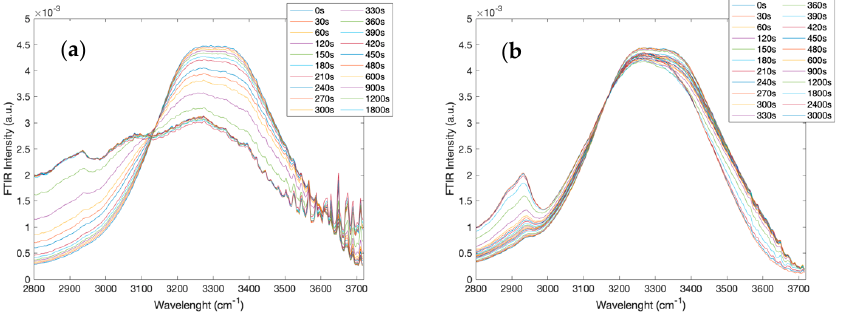
2800–3700 cm − 1 , for the creatine aqueous solution ( a ) and for the creatine aqueous solution in the presence of trehalose on ( b